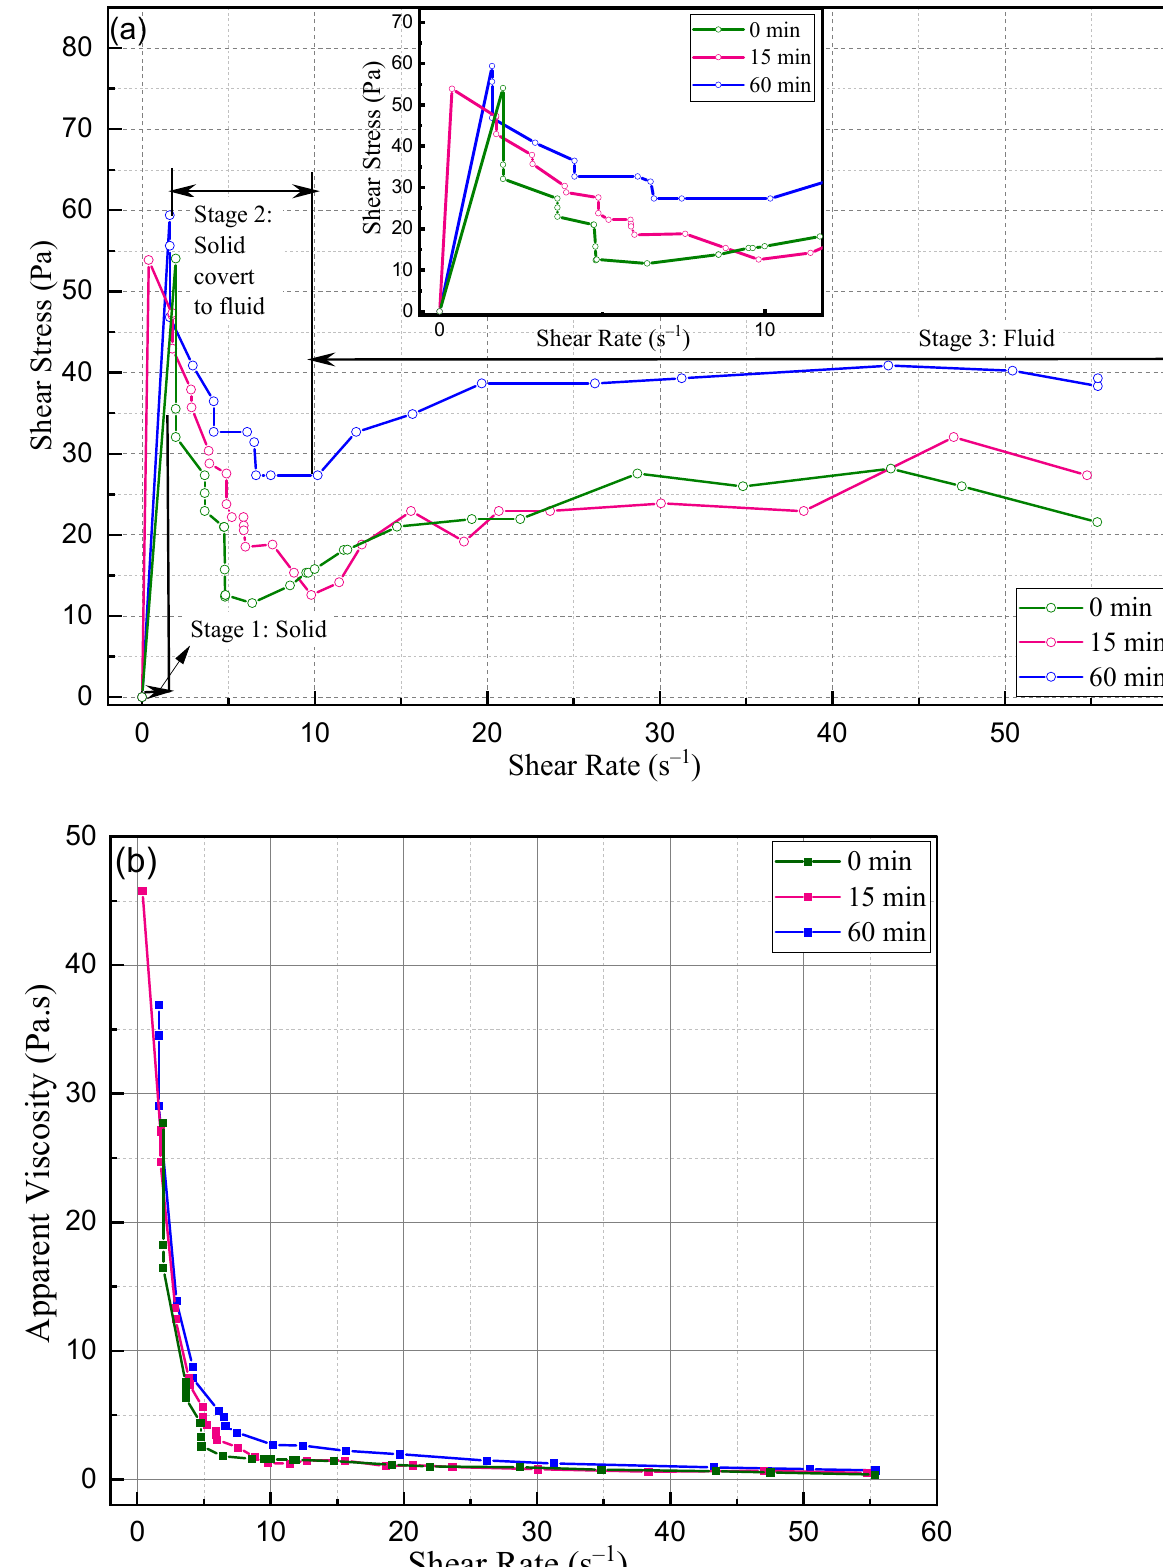
Figure 3. ( a ) Rheological curves of liquefied sediments. The insert figure is an enlargement of the left side. ( b ) Curves of apparent viscosity under different shear rates.